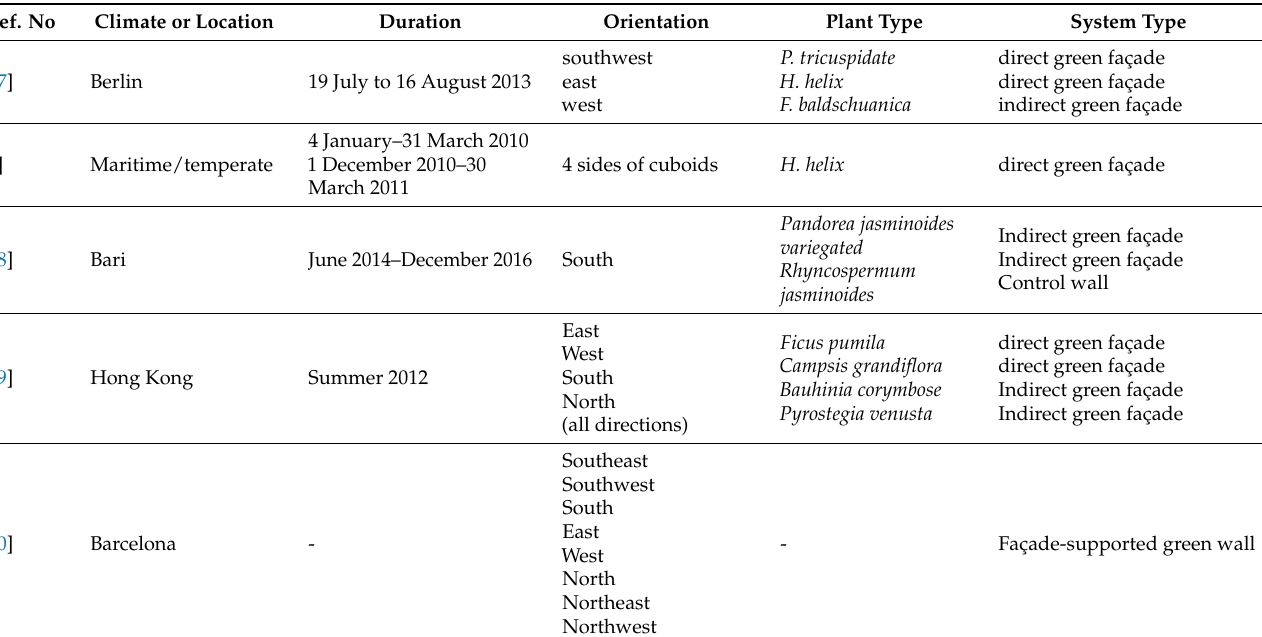
Table 1. Experimental and simulative studies examined in the location and orientation section of the